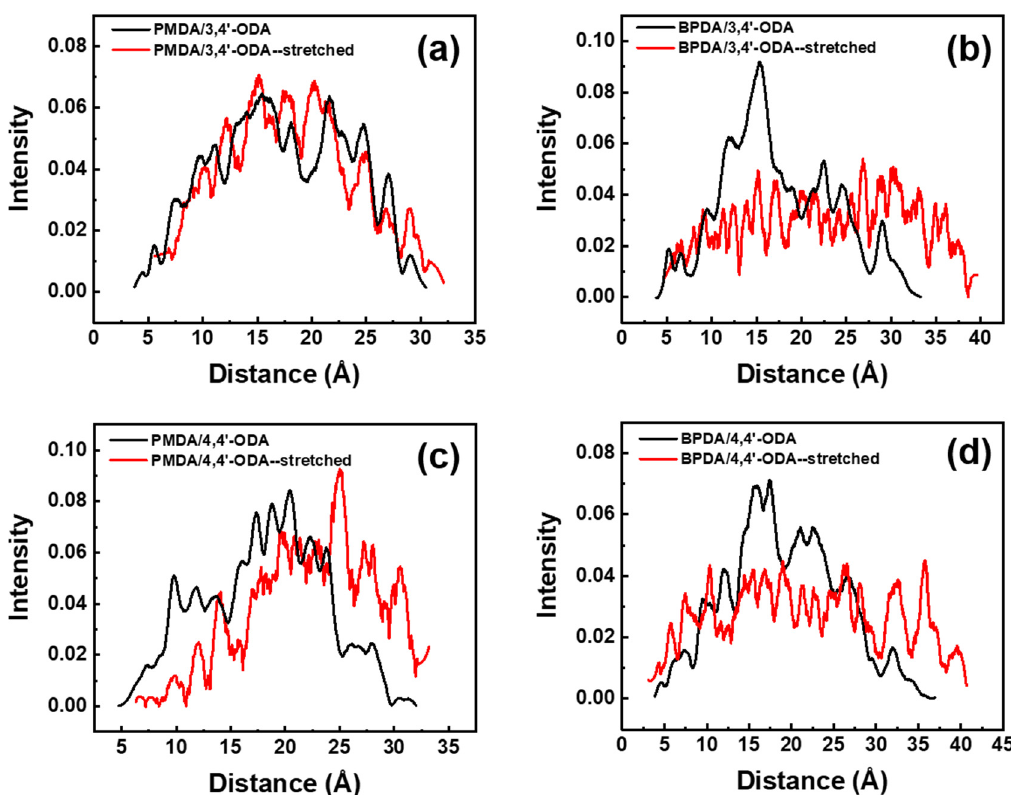
Figure 6. The distribution of two repeat unit lengths before and after stretching of different systems of PI. ( a ) PMDA/3,4 ′ - ODA; ( b ) BPDA/3,4 ′ -ODA; ( c ) PMDA/4,4 ′ -ODA; ( d ) BPDA/4,4 ′ -ODA.